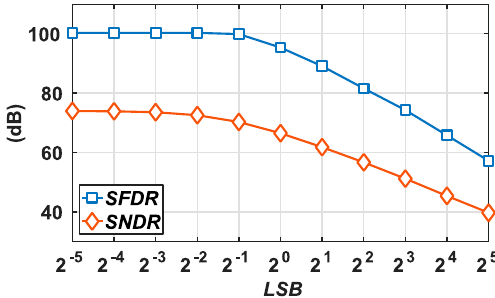
Figure 3. The dynamic performance of a behavioral simulation for a 12-bit SAR ADC using a supply voltage as a reference voltage according to a RMS value of the supply fluctuation.